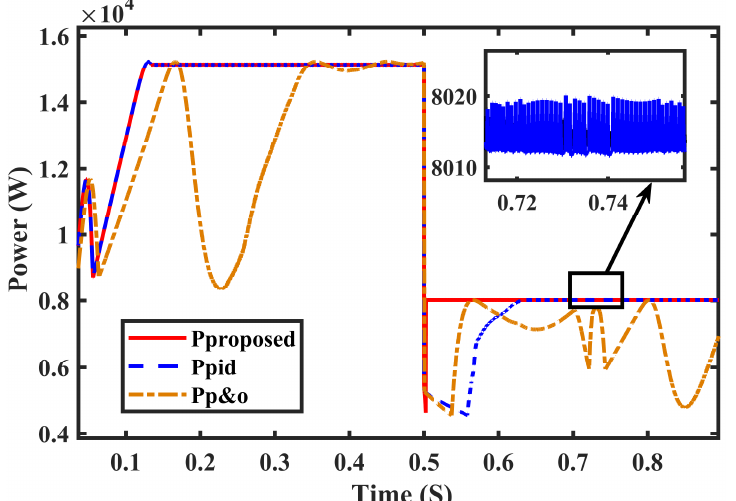
Figure 14. Power analysis without uncertainties.